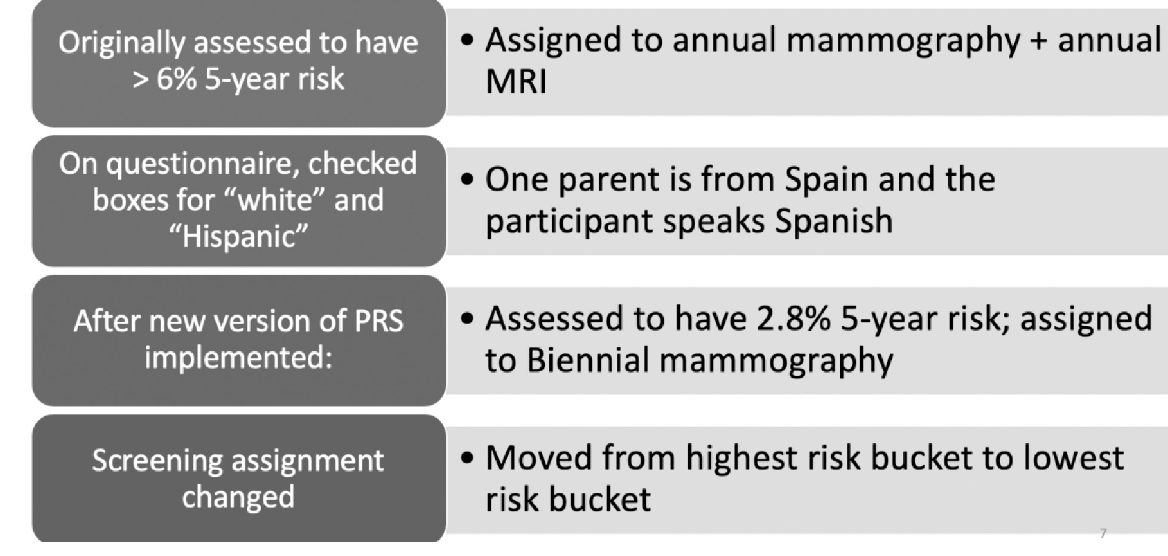
Fig 5. WISDOM participant